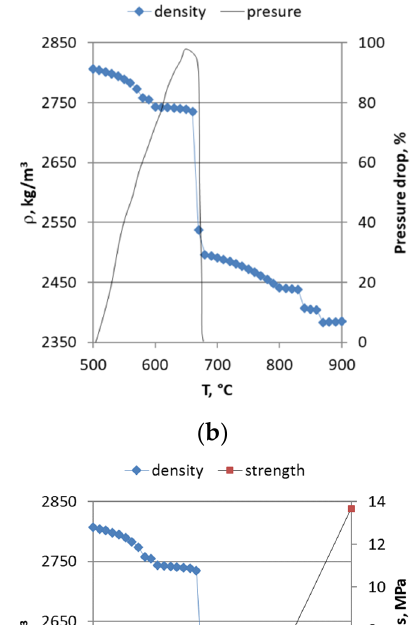
Figure 7. Rye straw: ( a ) Specific heat (c p ) and pressure drop as a function of temperature; ( b ) den- sity (  ) and pressure drop as a function of temperature; ( c ) specific heat and fracture stress as a function of temperature; ( d ) density and fracture stress as a function of temperature.